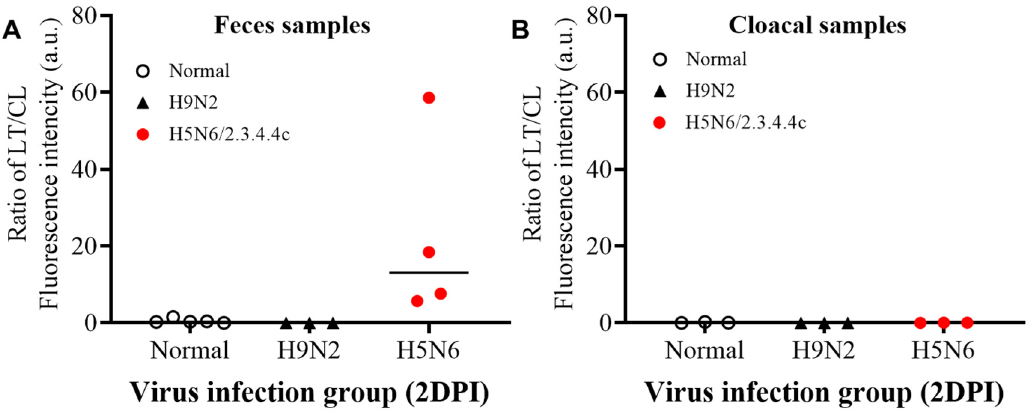
Figure 9. Performance of FICT for H5 HPAIVs detection in fecal samples. Viruses were inoculated into 4-weeks-old specific-pathogen-free chicken. Fresh stool and cloacal samples were collected 2 days post infection (2DPI) and then subjected to FICT, Au NPs-RDT, and RT-PCR assays to determine the sensitivity of diagnostic tests. ( A ) TL/CL ratio in fecal samples. ( B ) TL/CL ratio in cloacal samples. H5N6 HPAI and H9N2 infection experiments were performed in the BSL3 and BLS2 laboratory, respectively. Raw data are shown in Supplementary Figure S12.